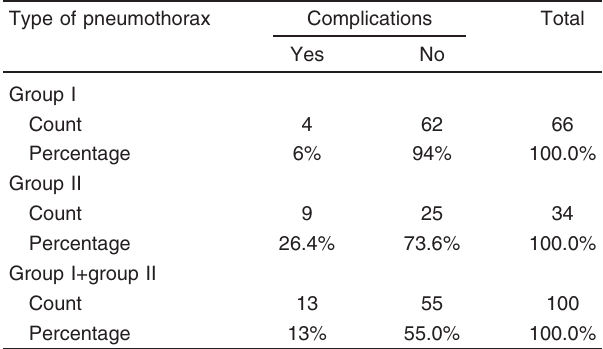
Table 5 Descriptive data of the complications in the studied patients